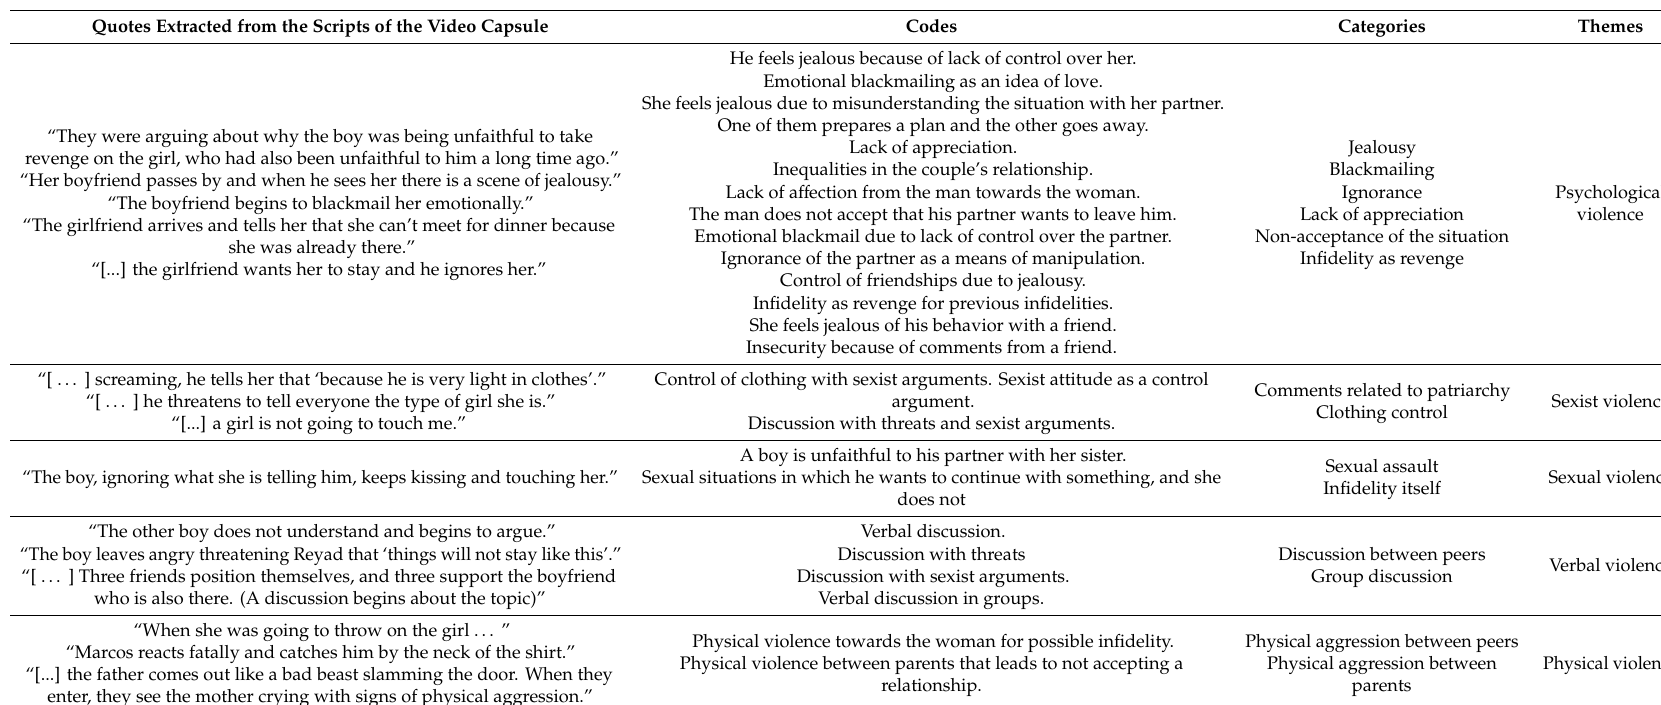
Table 3. Summary of the patterns of violence identified with their codes, categories and themes obtained after open-coding analysis. Quotes Extracted from the Scripts of the Video